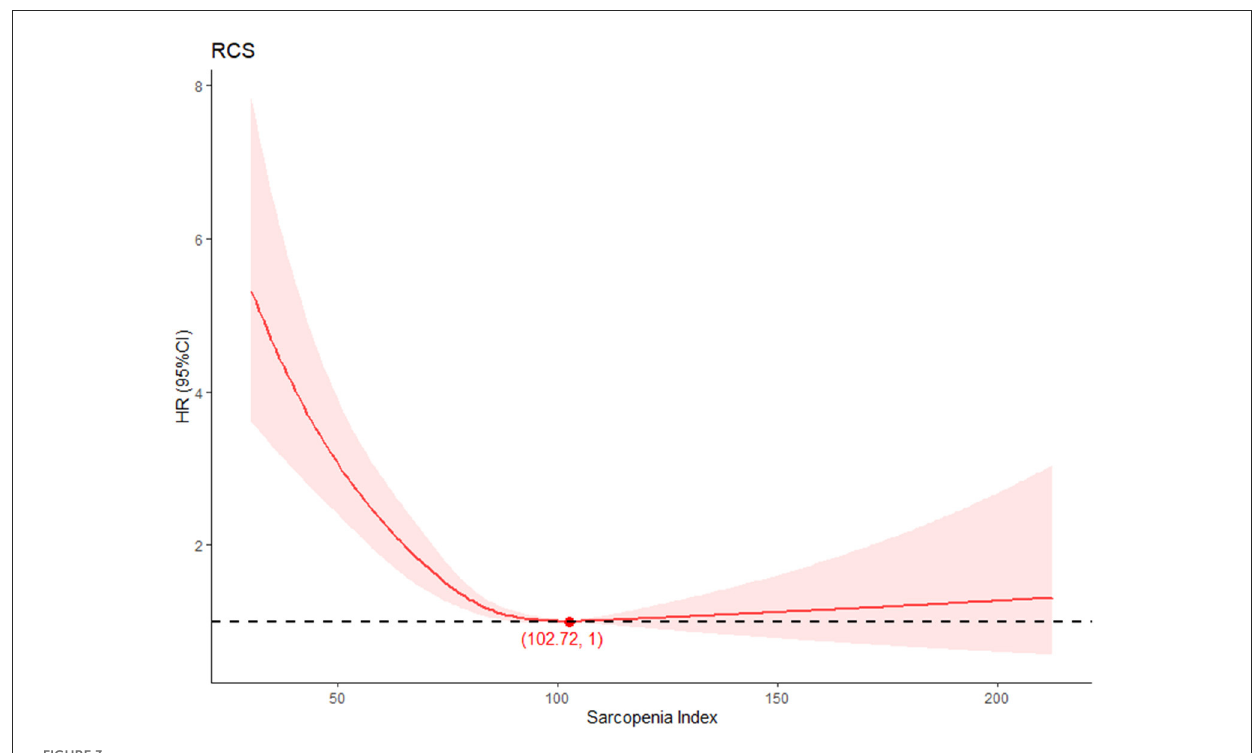
FIGURE3 Dose-response relationship between SI level and all-cause